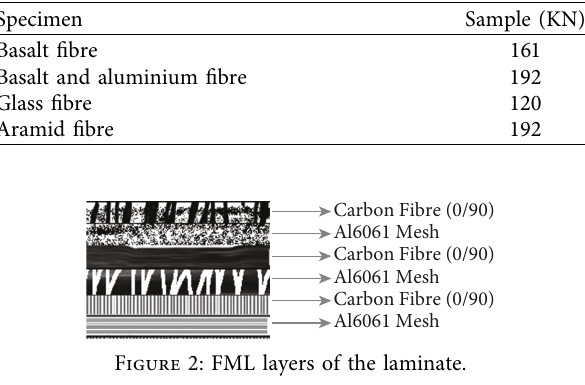
Table 2: experimental value for tensile strength.